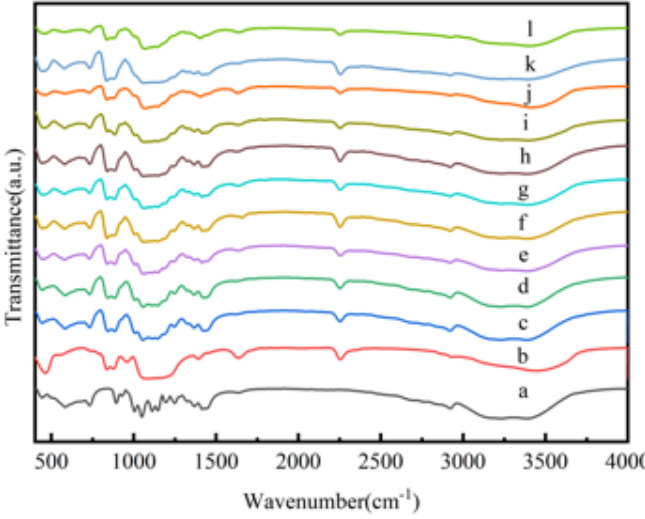
Figure 3. FT −− IR spectra of ( a ) inositol, ( b ) SiO 2 and the nanocapsules ( c ) NeIN1; ( d ) NeIN2; ( e ) NeIN3; ( f ) NeIN4; ( g ) NeIN5; ( h ) NeIN6; ( i ) NeIN7; ( j ) NeIN8; ( k ) NeIN9; (l) NeIN10.